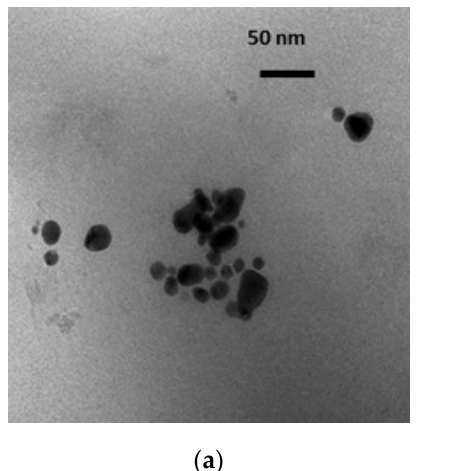
Figure 11. Comparative FTIR spectra of initial extracts and of their derived nanoparticles: AgNPs-H 2 O ( A ) and AgNPs-EtOH ( B ).